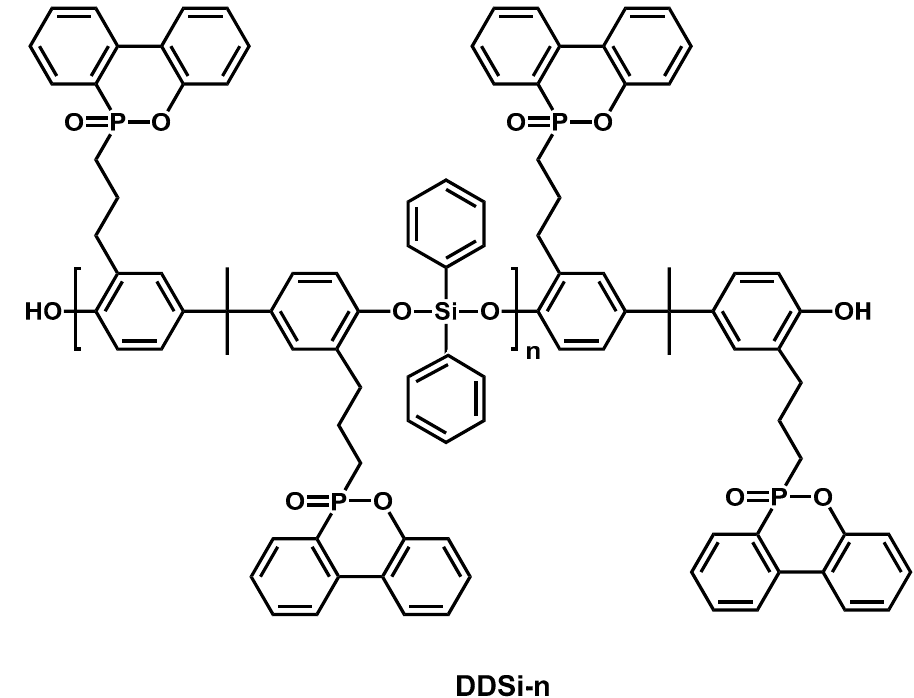
Figure 15. Chemical structure of the contrastive DDSi-n. Readapted with permission from Ref. [144], Copyright 2019, Elsevier Ltd.